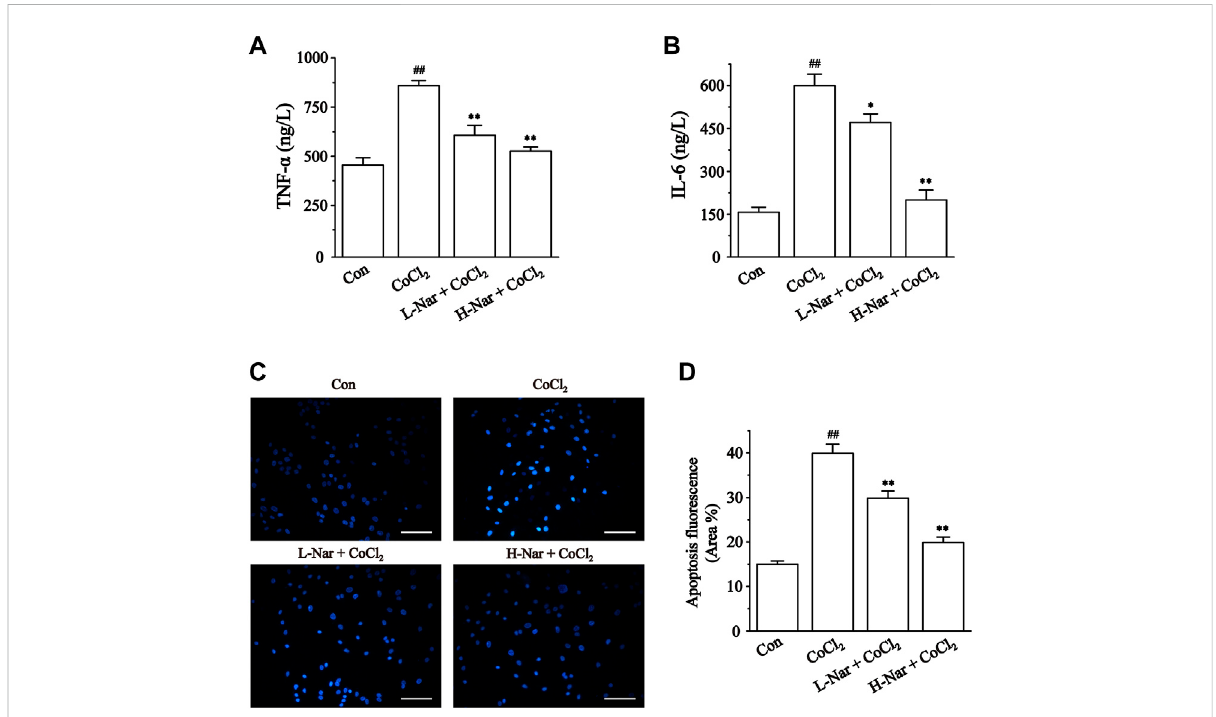
FIGURE 7 Effects of Nar on CoCl 2 -induced in fl ammation and apoptosis in H9c2. (A) TNF- α and (B) IL-6 were detected by ELISA. (C) Cardiomyocyte apoptosis was assessed by Hoechst 33258 staining (scale bar: 100 μ m; magni fi cation: ×200). (D) Statistical analysis of apoptosis fl uorescence was presented. Data were expressed as the mean ± SEM of each group. ## p < 0.01 vs. Con group; * p < 0.05, ** p < 0.01 vs. CoCl 2 group, n = 6 each group. Note: L-Nar: 10 μ M and H-Nar: 30 μ M.